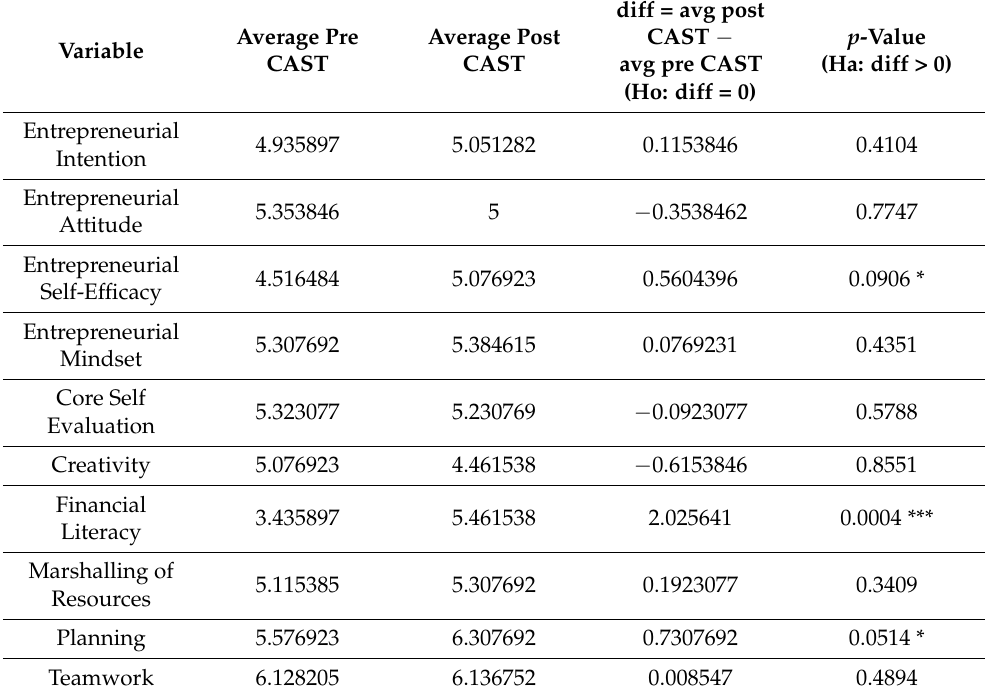
Table A3. Output of t -tests on entrepreneurial characteristics, pre- and post-course, of the female